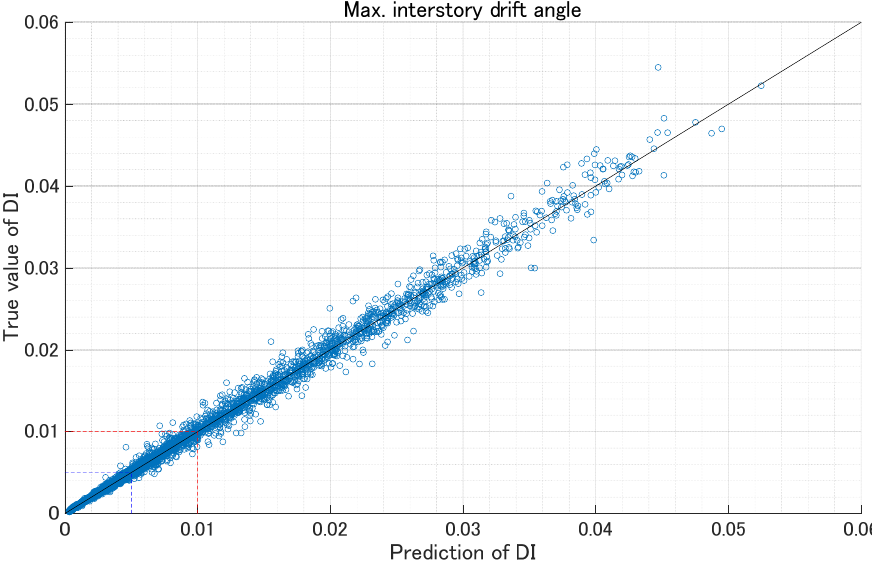
Figure 9. Scatter plot between the estimated and true values for the maximum IDA.